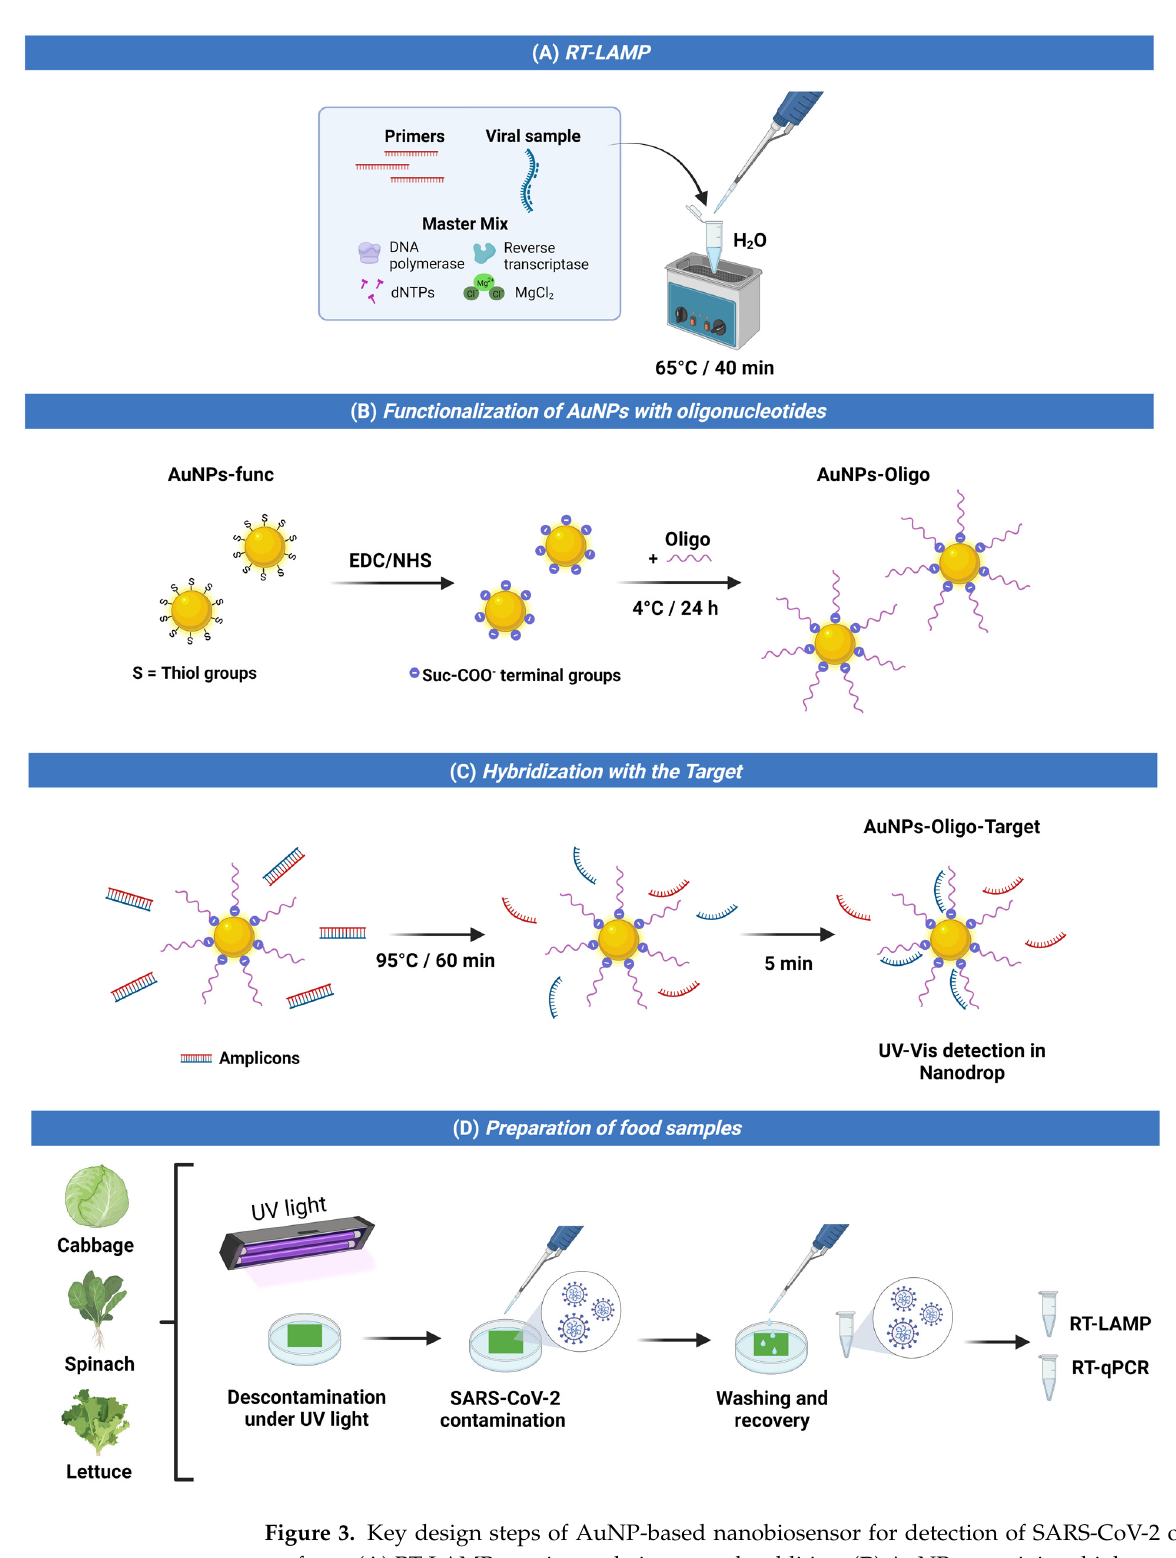
Figure 3. Key design steps of AuNP-based nanobiosensor for detection of SARS-CoV-2 on food surfaces: ( A ) RT-LAMP reaction and virus sample addition; ( B ) AuNPs containing thiol groups were functionalized with oligonucleotides; ( C ) separate amplicons bind oligonucleotide groups to the target for further detection in UV–Vis; ( D ) in natura samples of vegetables (cabbage, spinach, and lettuce) decontaminated with UV light were infected with SARS-CoV-2 and recovered for RT-LAMP and RT-qPCR reactions.